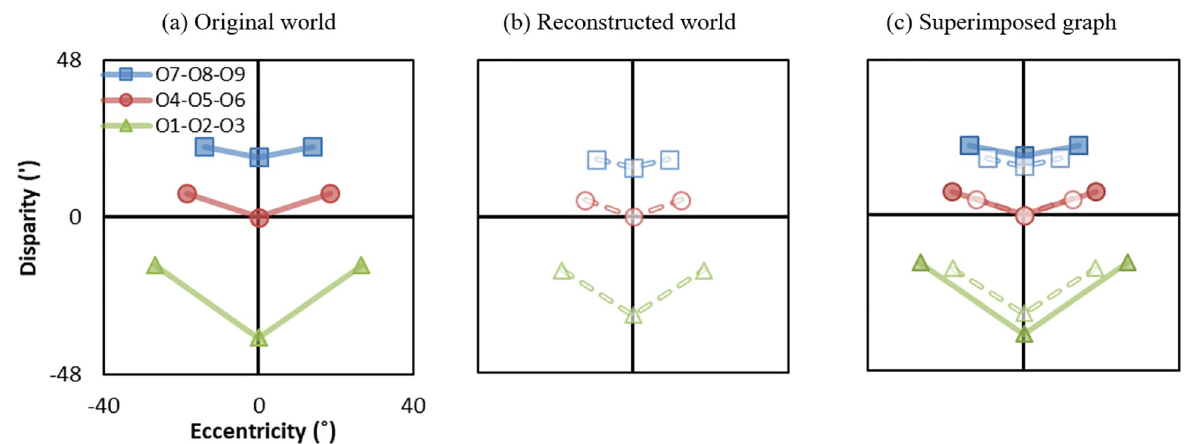
Fig 4. Example of geometric distortions presented in eccentricity-disparity ( E spaced rectilinear grid (3 × 3 in x − z plane), as shown in Fig 3. (a) Solid lines represent the eccentricity-disparity in the original world and (b) dashed lines represent the eccentricity-disparity in the reconstructed world in the condition where the separation ratio is k = 0.67, the FOV ratio is k f = 0.66, the convergence distance is d c = 3 m . (c) Superimposed eccentricity-disparity graph of the original world and reconstructed world. In subsequence figures, the superimposed graphs are presented to aid the visualization of distortions.